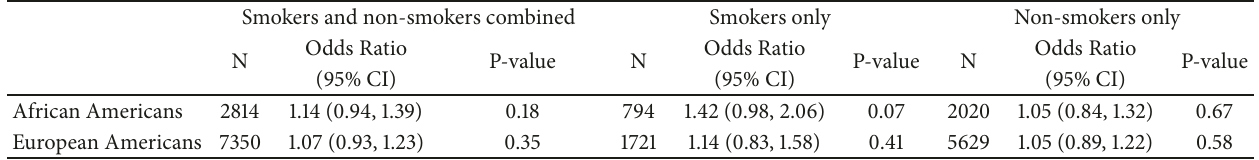
Table 3: Association between E158K in FMO3 and hypertension, stratified by current smoking status and race in the ARIC study.